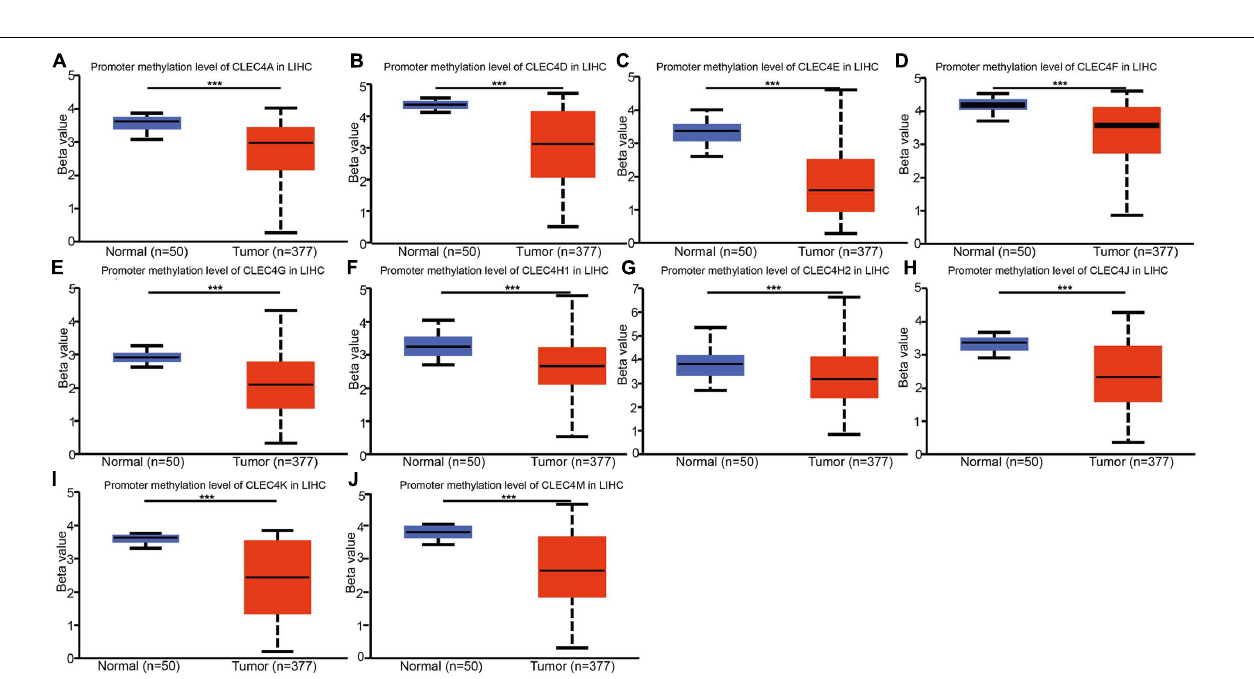
FIGURE 6 | Promotor methylation levels of CLEC4s in HCC tissues and adjacent normal liver samples. Promoter methylation expression levels of 10 CLEC4s were found to be downregulated in primary HCC tissues compared to normal controls. (A) CLEC4A; (B) CLEC4D; (C) CLEC4E; (D) CLEC4F; (E) CLEC4G; (F) CLEC4H1; (G) CLEC4H2; (H) CLEC4J; (I) CLEC4K; (J) CLEC4M. *** p <